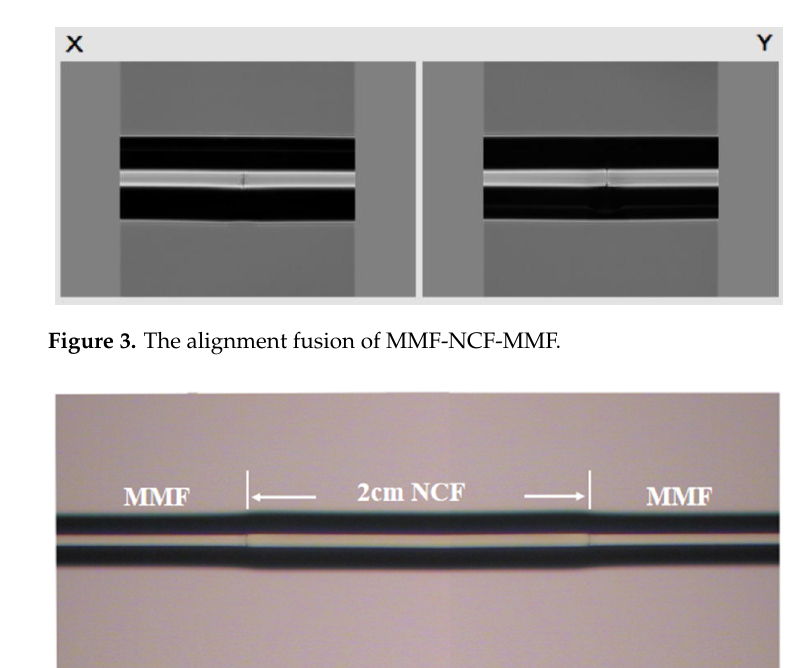
Figure 2. Fabrication process of MMF-NCF-MMF SPR sensor probe.